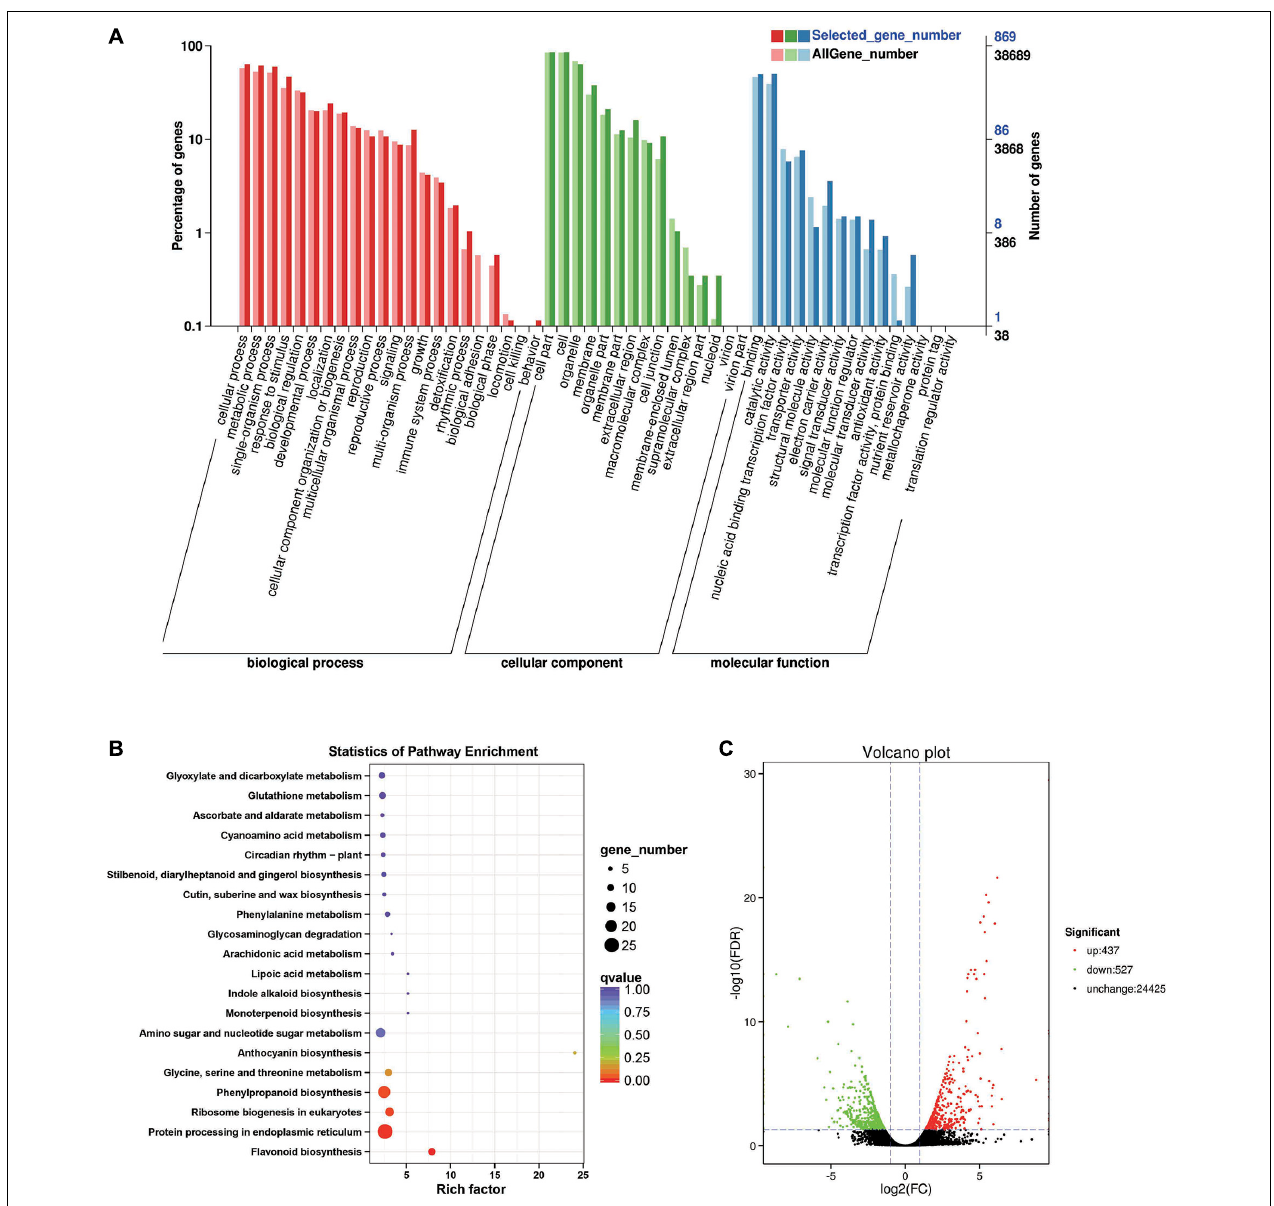
FIGURE 4 | Enrichment analysis of differentially expressed genes between C4 and C3 groups. (A) GO classification statistics of differentially expressed genes. It mainly includes three branches: biological process, cellular component, and molecular function. (B) The KEGG pathway enrichment statistics of differentially expressed genes. (C) Volcano plot statistics of the number of differentially expressed genes. C3: BcL.2-25 , C4: BcL.2-4